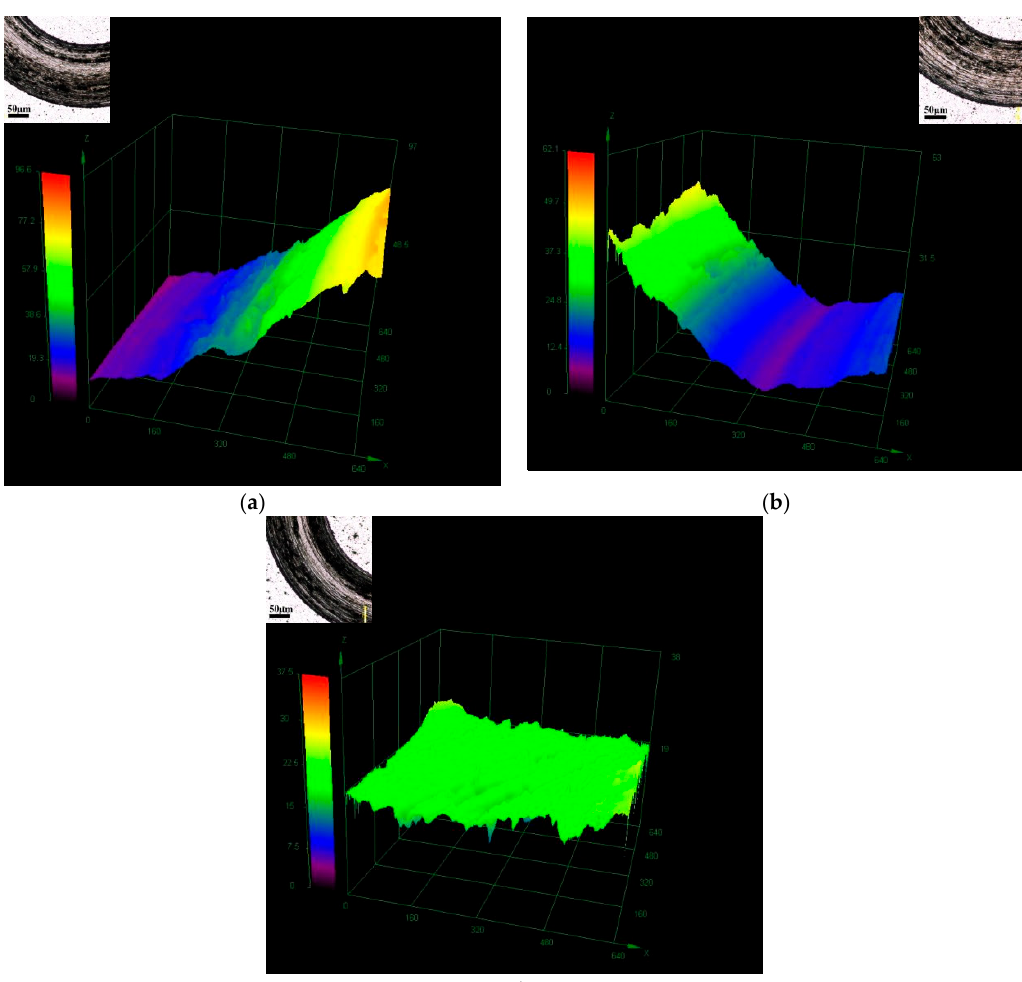
Figure 9. Three-dimensional (3D) non-contact surface mapping of the wear scars of ( a ) NiCr–5TiB 2 –5ZrB 2 ; ( b ) NiCr–10TiB 2 –10ZrB 2 ; and ( c ) NiCr–15TiB 2 –15ZrB 2 .